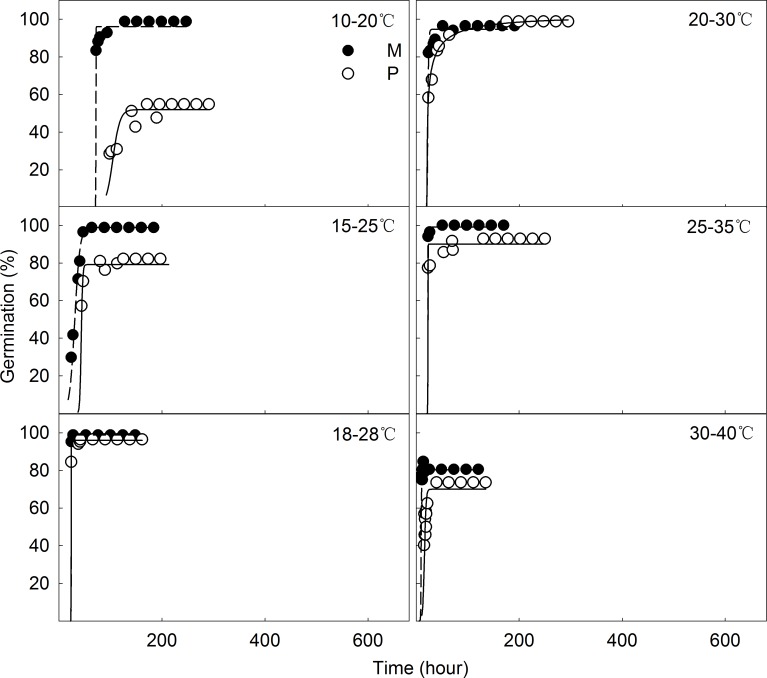
Cumulative M (solid dot) and P seeds (hollow dot) germination time-courses of C. pauciflorus under seven temperature regimes.